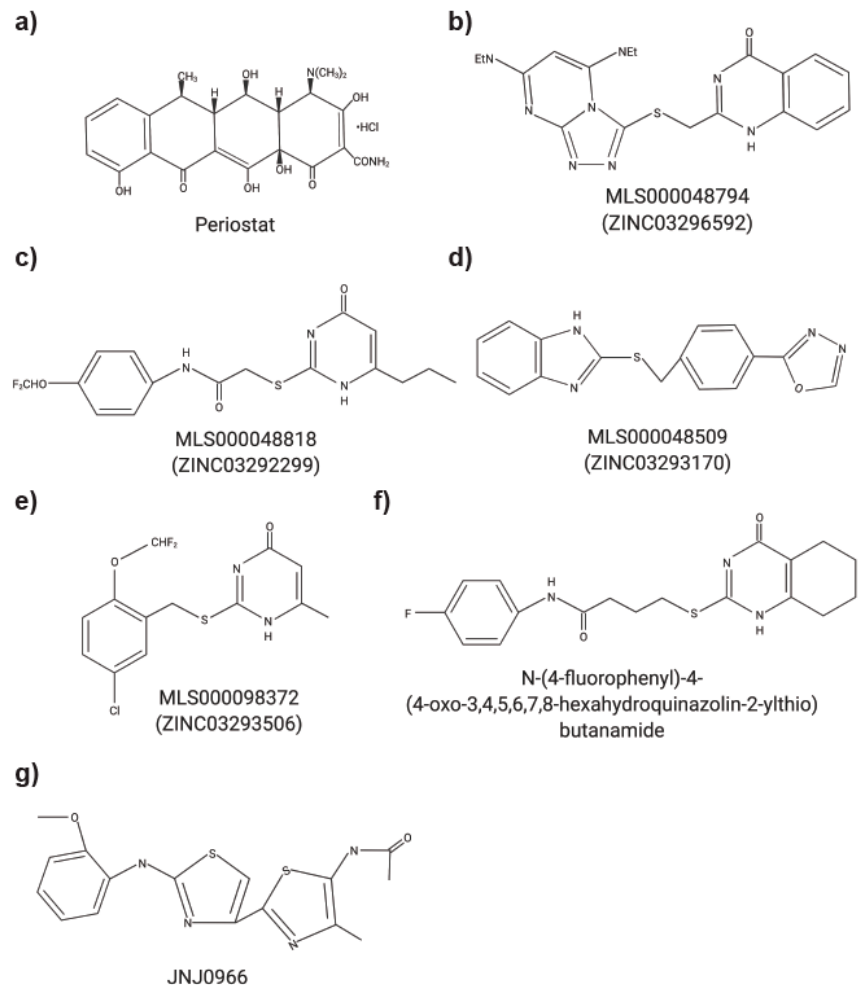
Figure 1. Chemical structures of small molecule MMP inhibitors. ( a ) Periostat ® : doxycycline hyclate. ( b ) MLS000048794: 2-[[3,5bis(ethylamino)-2,4,6,8,9-pentazabicyclo[4 .3.0]nona-2,4,7,9-tetraen- 7yl] sulfanyl-methyl]-1H-quinazolin4-one). ( c ) MLS000048818: N -[4-(difluoromethoxy)phenyl]-2-